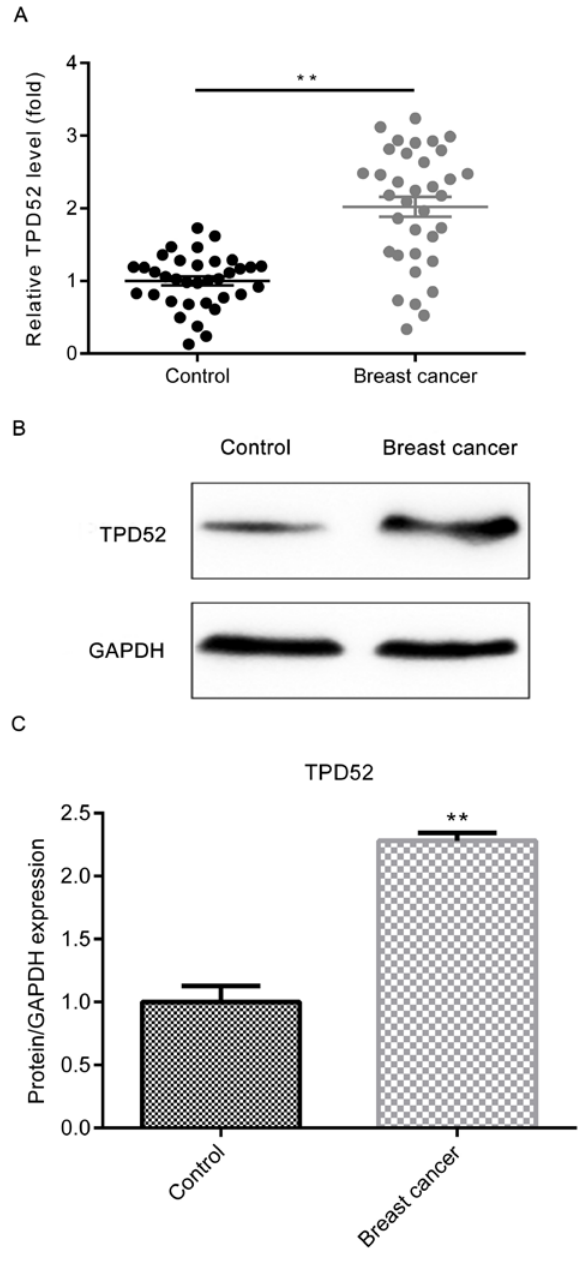
Figure 3: The expression level of TPD52 is up-regulated in breast cancer tumor tissues. (A) Relative TPD52 mRNA expression level in breast cancer tumor tissues and non-tumor adjacent tissues was compared by RT-qPCR assay. (B) Relative protein expression level of TPD52 in breast cancer tumor tissues and non-tumor adjacent tissues was compared by western blot assay. (C) The quantitative result of B was presented. **P<0.01, vs control group. Control, non- tumor adjacent tissues; breast cancer, breast cancer tumor tissues; TPD52, tumor protein D52; GAPDH, glyceraldehyde 3-phosphate